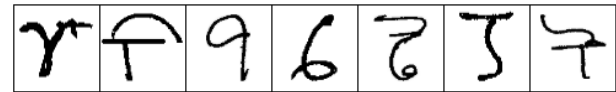
Figure 3. Bengali Modifiers Samples from CMATERdb